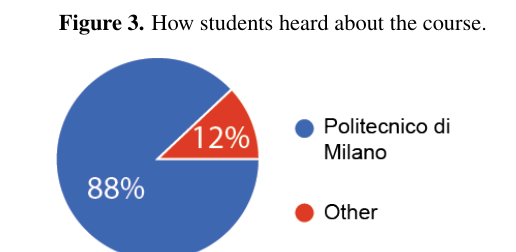
Figure 3. How students heard about the course.